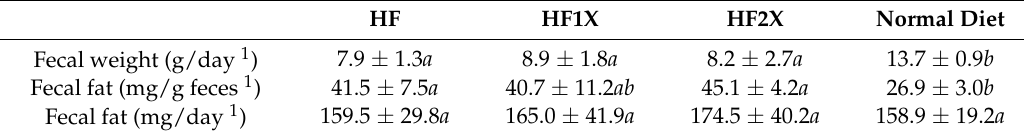
Table 3. Fecal weight and fats of the rats fed high-fat diets.